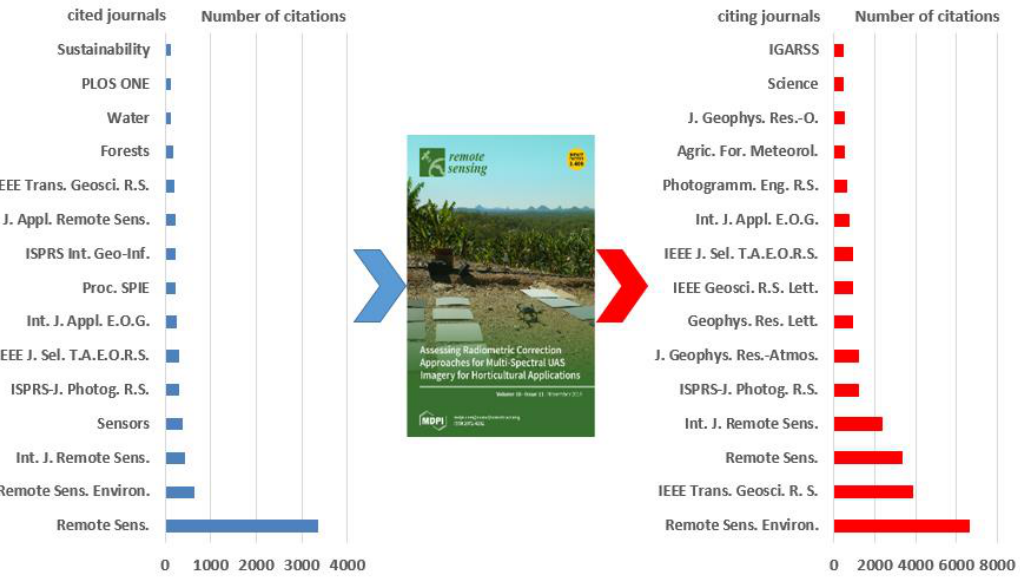
Figure 10. Knowledge flow into and from Remote Sensing Open Access Journal (RS OAJ) of MDPI during 2009–2018 time-period. The left side shows the articles of the Journals that are cited in RS OAJ articles frequently and on the right side are the Journals that cite RS OAJ frequently. Note: IEEE Trans. Geosci. R.S. (IEEE Transactions on Geoscience and Remote Sensing), Int. J. Appl. E.O.G. (International Journal of Applied Earth Observation and Geoinformation), IEEE J. Sel. T.A.E.O.R.S. (IEEE Journal of Selected Topics in Applied Earth Observations and Remote Sensing), ISPRS-J. Photo.R.S. (ISPRS Journal of Photogrammetry and Remote Sensing), J. Geophys. Res.-O. (Journal of